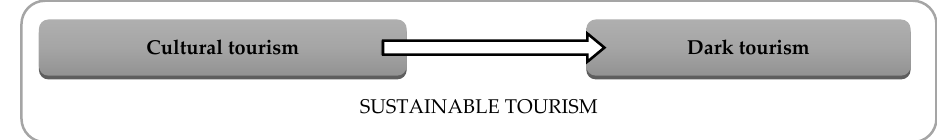
Figure 5. Dark Tourism and Cultural Tourism as Sustainable Tourism.